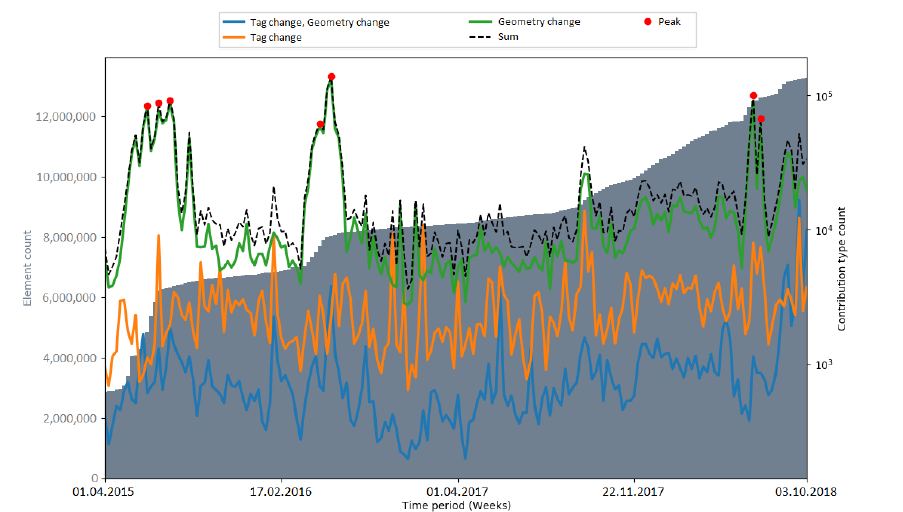
Figure A13. Contribution types during the AND import.